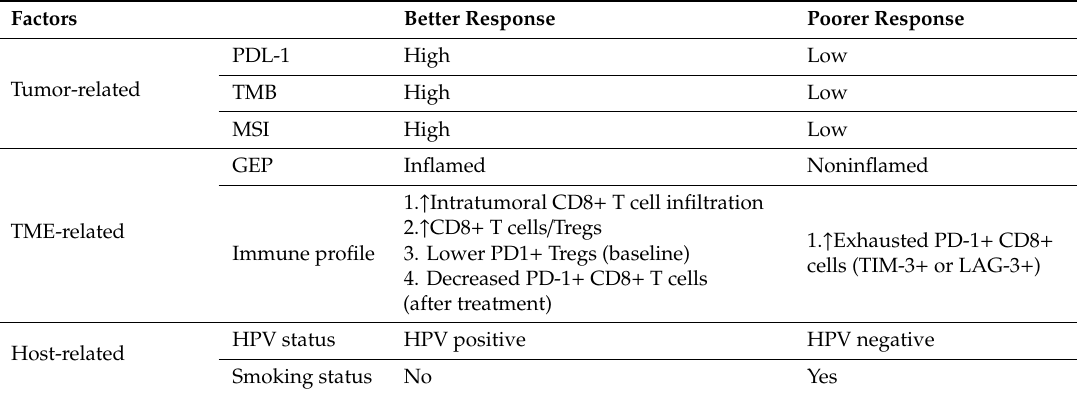
Table 2. Summary of biomarkers that have the potential to predict the clinical e ffi cacy of immune checkpoint inhibitors in head and neck